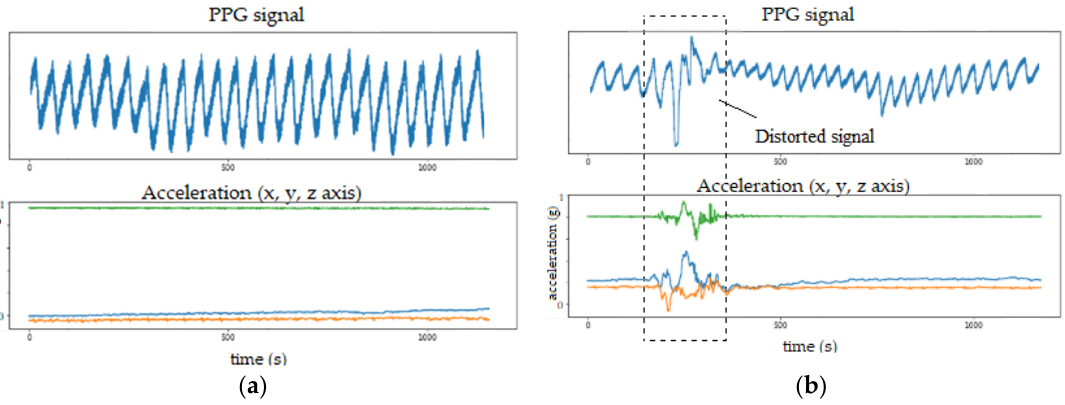
Figure 7. Illustration of the effect of motion on PPG signals: ( a ) clean PPG waveform when no motion is present; ( b ) PPG signal affected by motion artifacts during movement.